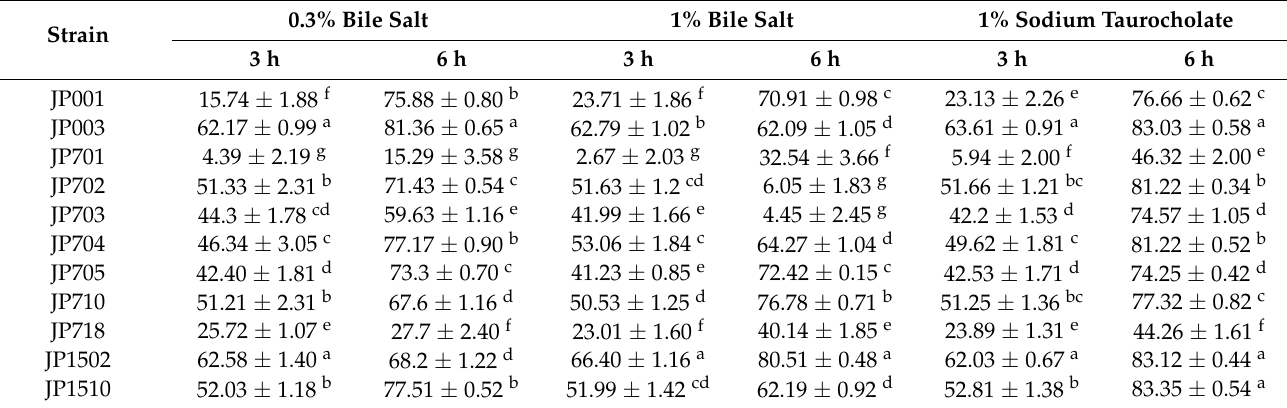
Table 3. Bile tolerances (%) of 11 LAB